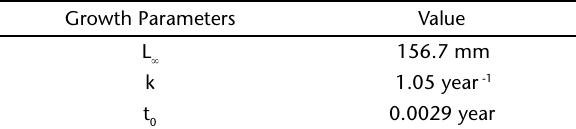
Table III. Parameters estimated for the von Bertalanffy growth ) using iterative method for C. edentulus in the model (L (cid:2) , k and t 0 Saco dos Limões bight (southern Brazil). Growth Parameters